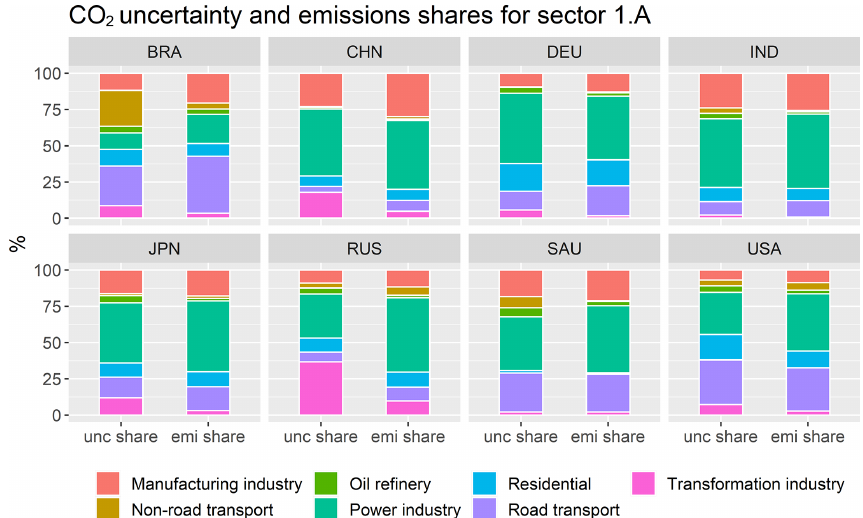
Figure 2. The CO 2 uncertainty and emission shares for EDGAR emission sectors under IPCC category 1.A for Brazil, China, Germany, India, Japan, Russia, Saudi Arabia, and the USA.